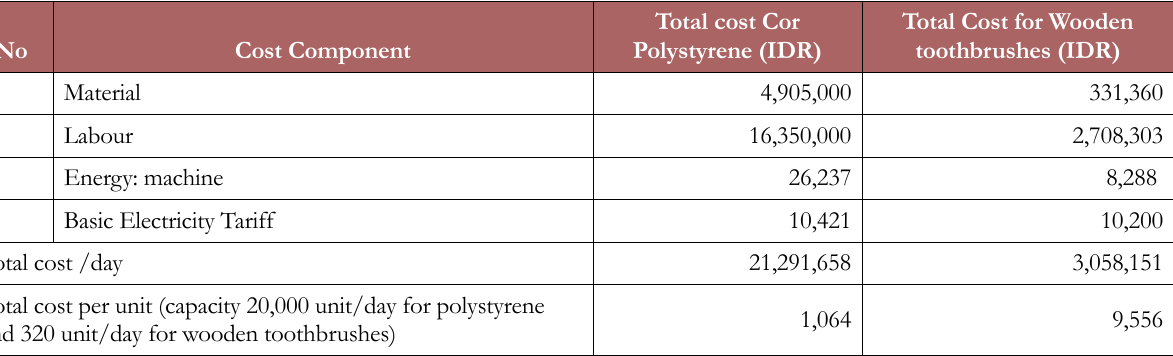
Table 5. The comparison of the cost of the production process